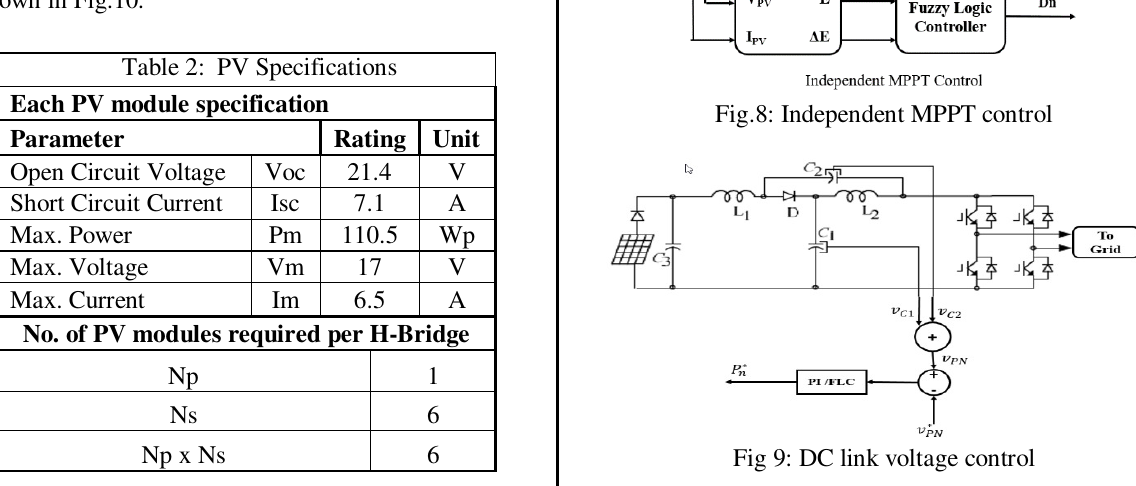
Fig.8: Independent MPPT control